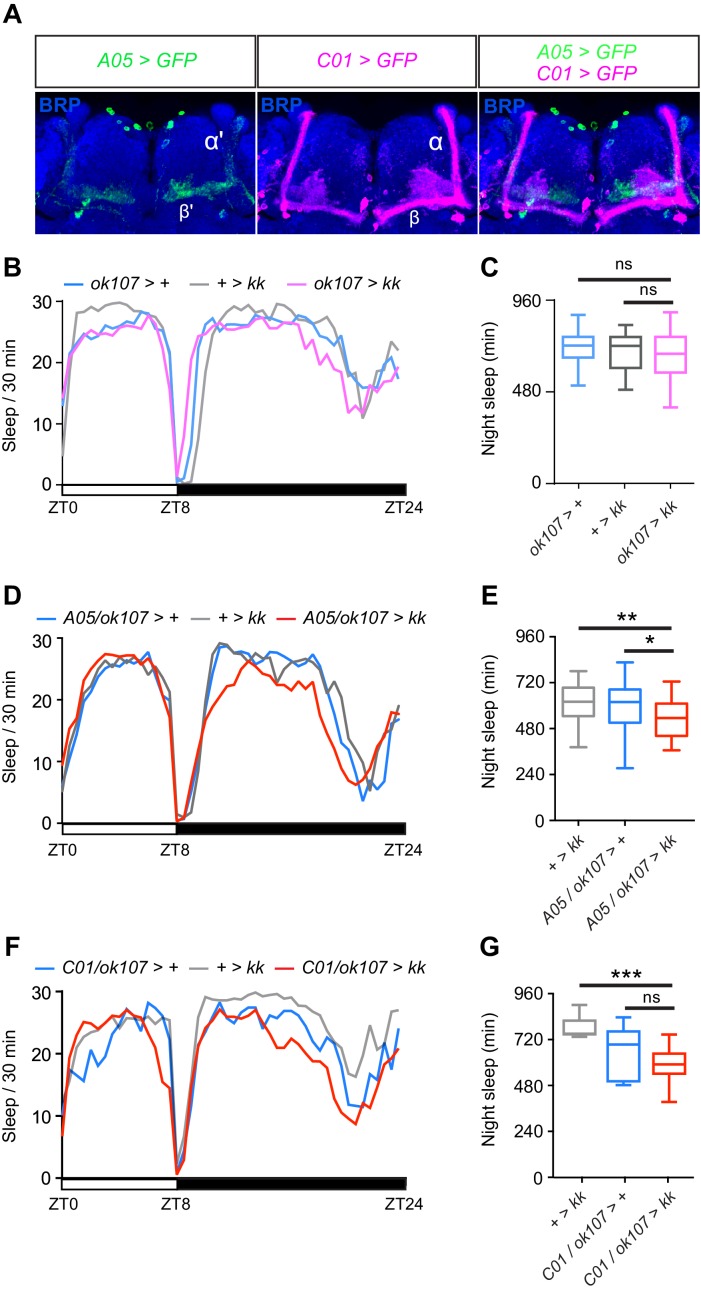
The mushroom bodies are a sleep-relevant subdomain within C01-neurons.(A) Standardised confocal stacks labelling R14A05 (A05 > GFP, green) and R72C01 (C01 > GFP, magenta) positive neurons. Images from Jenett et al. (2012), deposited at the Virtual Fly Brain, www.virtualflybrain.org), were downloaded and digitally superimposed (right panel) onto the universal fly brain (the image source data is distributed under a CC BY-NC-SA 4.0 license). BRP, Bruchpilot. (B–C) Mean sleep pattern (B) and median night sleep levels (C) in adult male flies expressing Nca RNAi (kk) in MB-KCs using ok107-gal4 in 8L: 16D. ok107 > +, n = 55, + > kk, n = 47, ok107 > kk, n = 65. (D–E) Nca knockdown in both A05 and MB-KC neurons results in reduced night sleep. Mean sleep patterns in 8L: 16D are shown in (D), median night sleep levels are shown in (E). A05/ok107 > +: n = 33, + > kk: n = 31, A05/ok107 > kk: n = 42. (F–G) Knocking down Nca in MB-KC and the C01-neurons does not result in significant night sleep loss in 8L: 16D. Mean sleep patterns are shown in (F), median night sleep levels are shown in (G). C01/ok107 > +: n = 11, + > kk: n = 15, C01/ok107 > kk: n = 21. ns – p>0.05, *p<0.05, **p<0.01, ***p<0.001, Kruskal-Wallis test with Dunn’s post-hoc test.